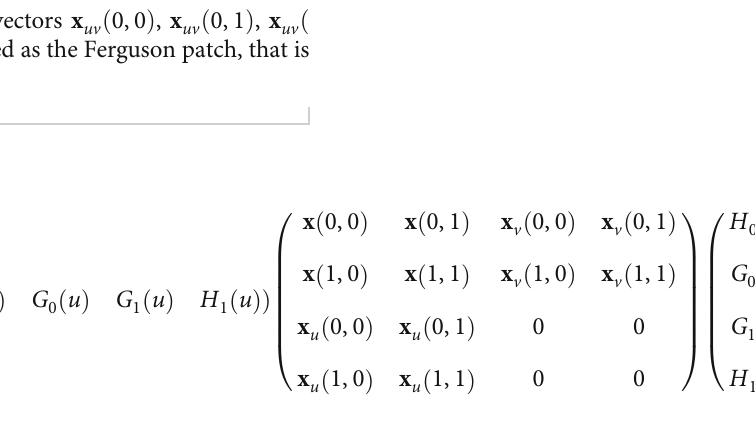
= 1 and v = 1 in the uv 2 , which is zero along the lines u